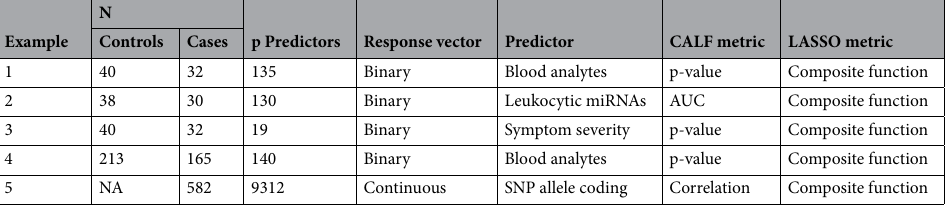
Table 1. Parameters of five data